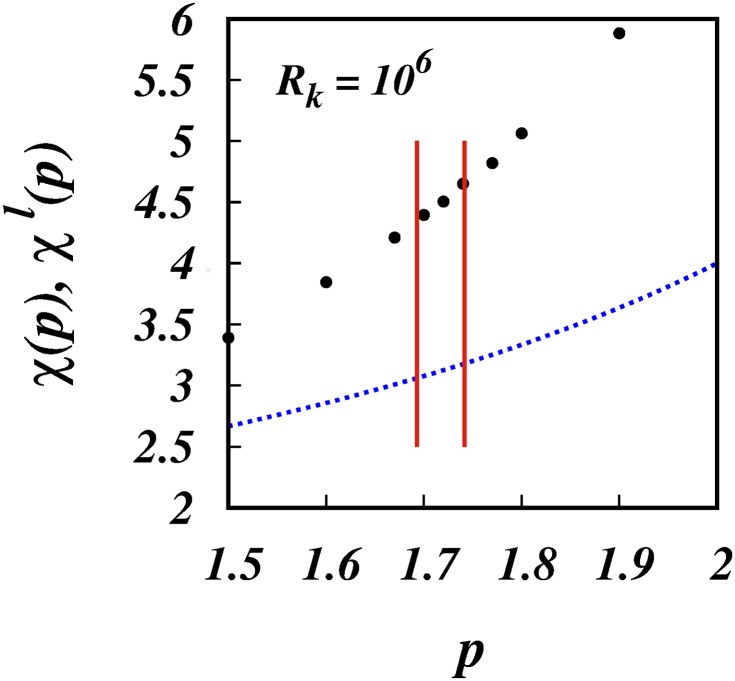
χ(p), χl(p), against p.Similar to Fig 4, but focussing in on the range of intermittency spectra. The two vertical red lines are the lower and upper bounds for intermittent turbulence spectra, respectively p = 1.70 and 1.74.